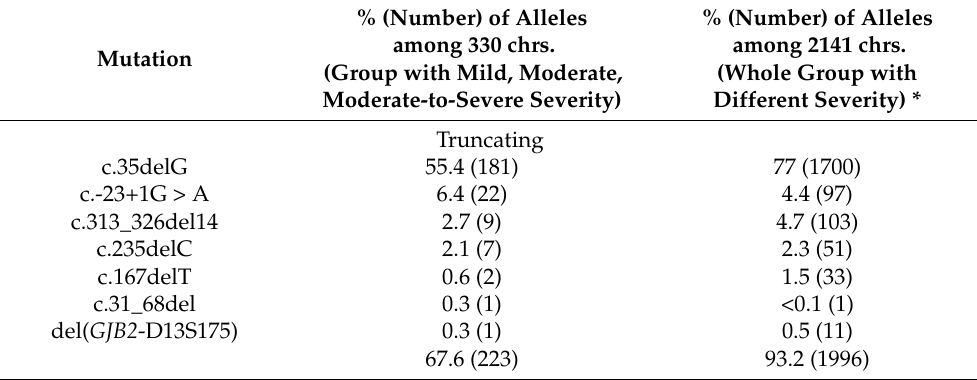
Table 1. The allele frequency of GJB2 variants in our group compared to our previous whole group with different